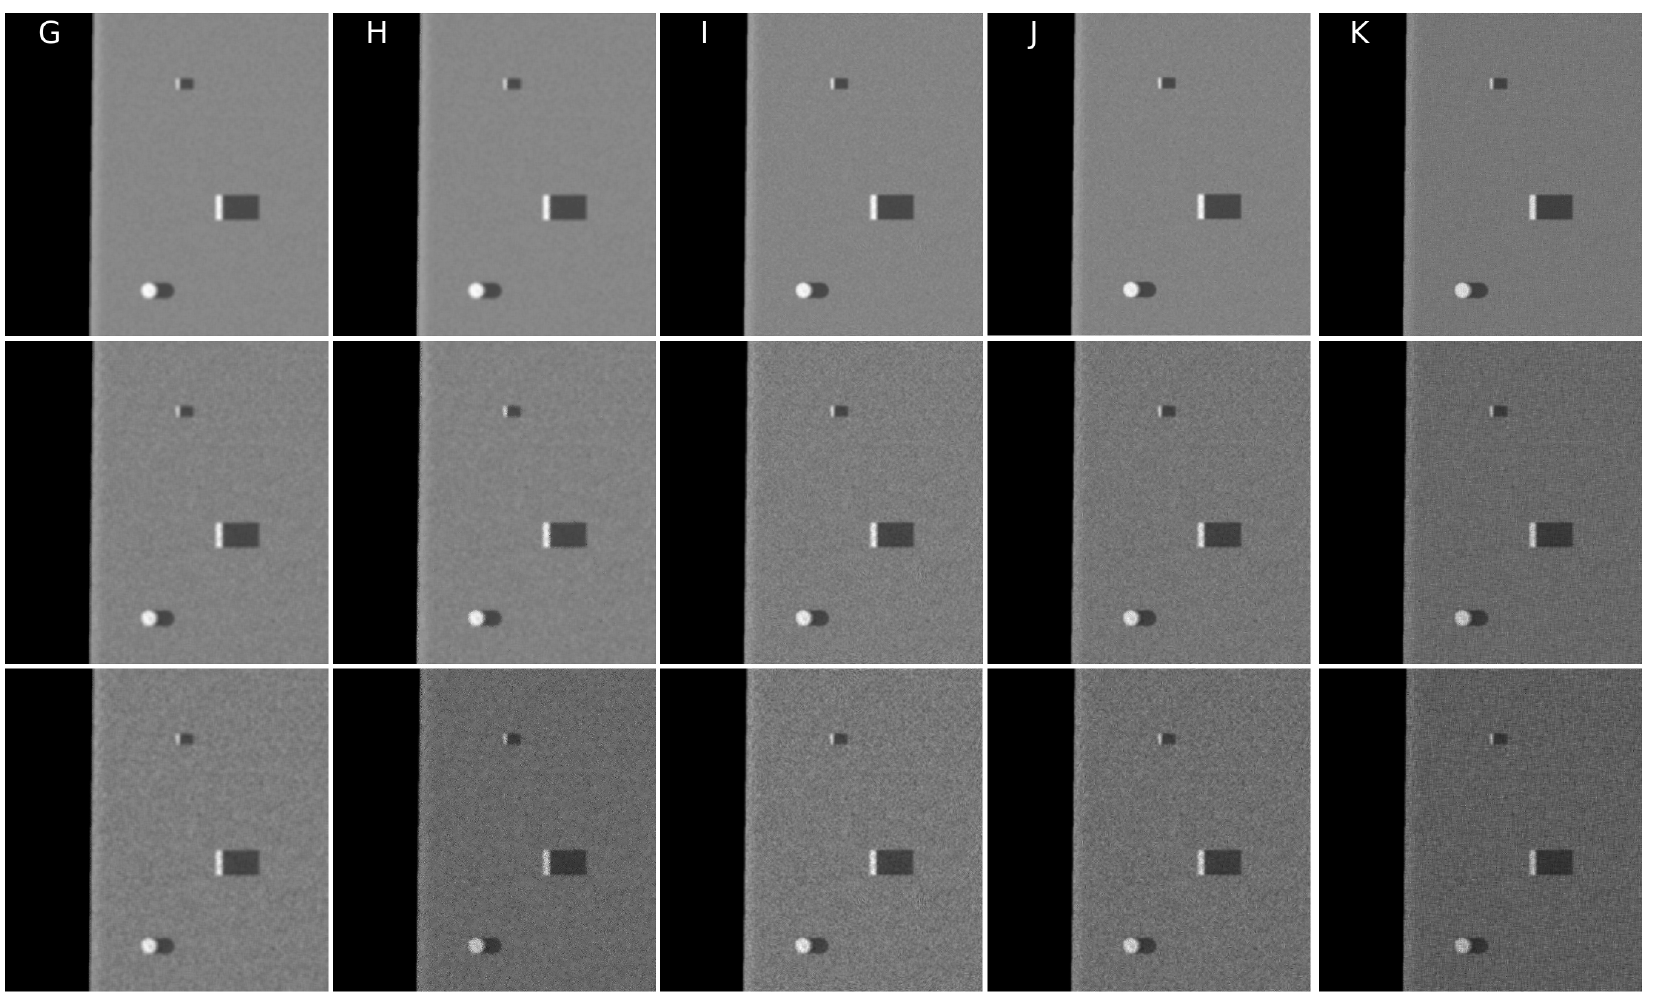
Figure 4. Filtering results comparison for different noise values. Top row σ 2 = 0.01, middle row σ 2 = 0.05, bottom row σ 2 = 0.1: ( A ) Original image; ( B ) noised image; ( C ) Mean; ( D ) Median; ( E ) Frost; ( F ) Lee; ( G ) Lee enhanced; ( H ) Kuan; ( I ) P1; ( J ) P2; and ( K )